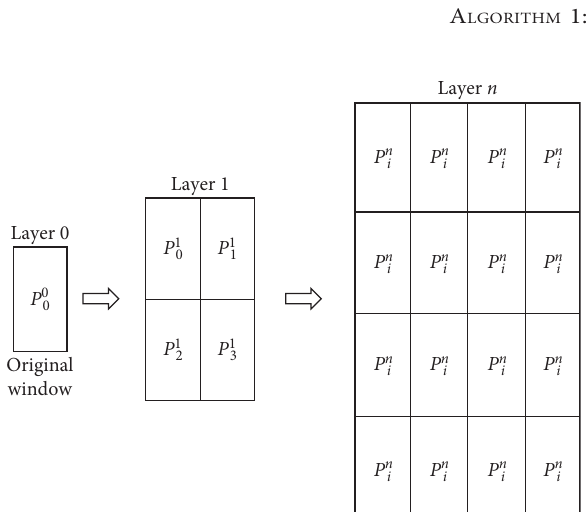
Figure 4: Pyramidal part representation. From left to right, the original input and that segmented into parts are